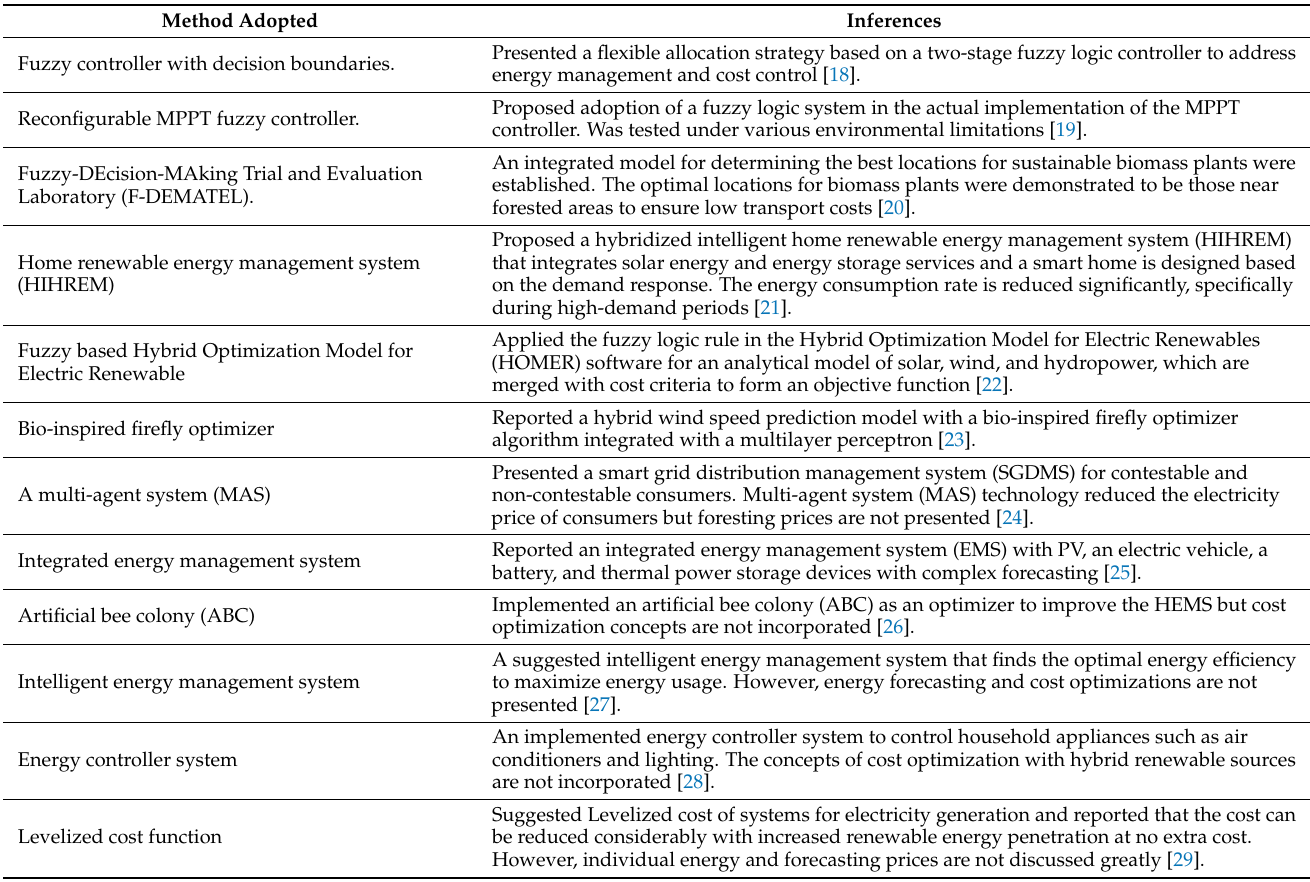
Table 1. Inferences from the existing